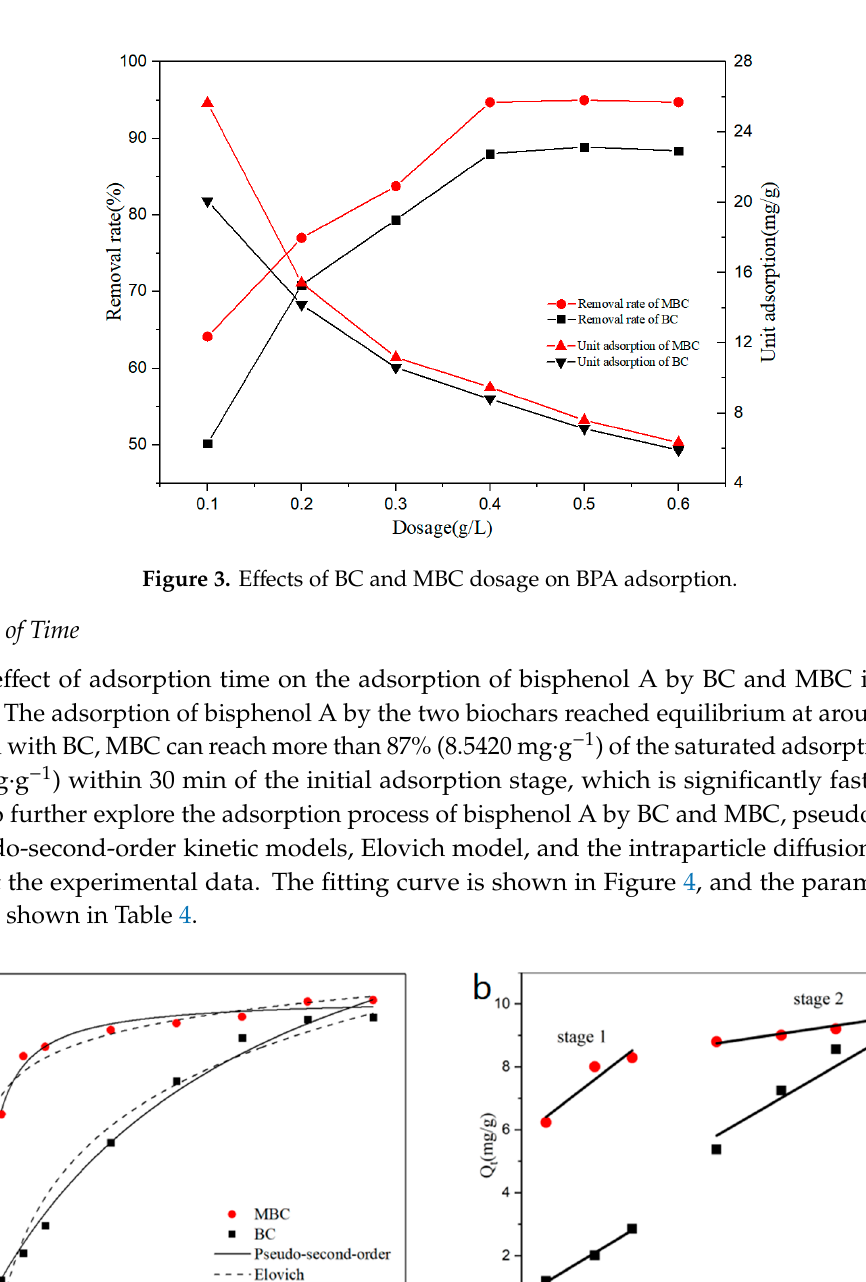
Figure 4. Effects of the adsorption equilibrium time on BPA adsorption and kinetic equation fitting: pseudo-second-order (P-S-O) and Elovich ( a ); intraparticle diffusion ( b ). Table 4. Fitting parameters of four kinetic models for adsorption of BPA onto BC and MBC.